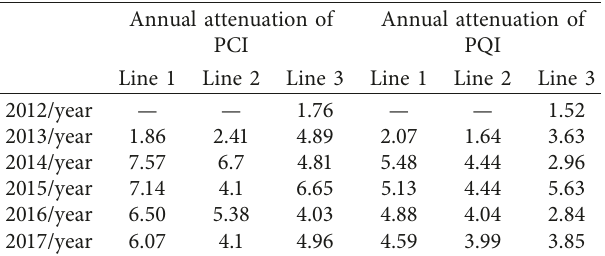
Condition number of the matrix Table 3: Annual attenuations of PCI and PQI for three repre- sentative lines of the main highway in Hunan